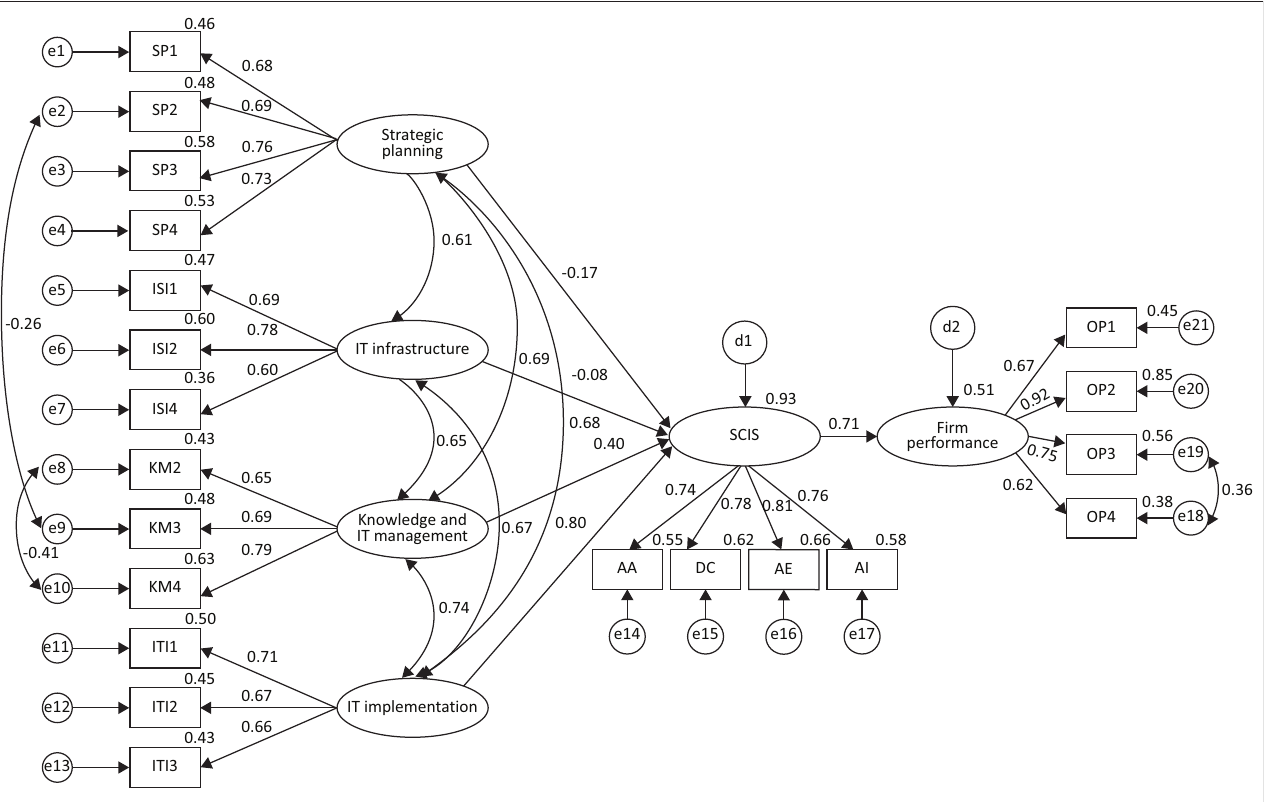
FIGURE 2 : Final structural